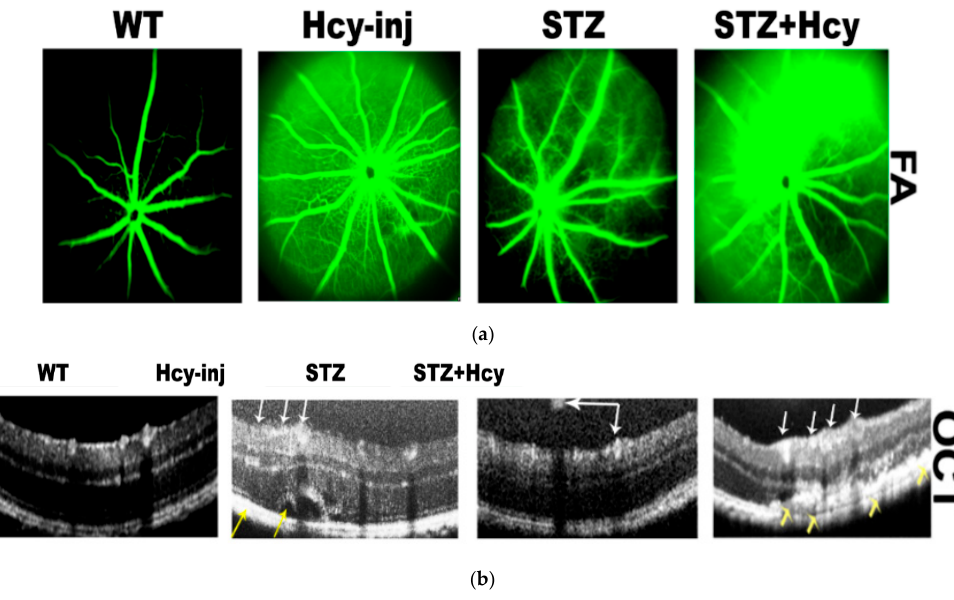
Figure 4. Retinal Fluorescein Angiography (FA) and Optical Coherence Tomography (OCT) assessment of wild-type (WT) mice, Hcy-intravitreal injected mice, STZ-injected mice and Hcy+STZ injected mice (8–10 weeks diabetic). FA demonstrated well-formed vessels in WT mice. FA for Hcy-injected mice showed hyperfluorescence, indicating vascular leakage. Similarly, the FA of STZ-injected mice showed decreased vessel integrity and a disrupted blood–retinal barrier (BRB), indicated by increased fluorescein leakage (pale green haziness). However, the FA of Hcy injected STZ- mice showed focal spots of hyperfluorescence, indicating more significant vascular leakage ( A ). OCT examination showed a typical normal architecture of retinal layers in WT mice, but a disruption of retinal morphology in Hcy-injected mice (white and yellow arrows). These changes were also observed in the OCT of STZ-injected mice. However, the OCT of Hcy+STZ injected mice demonstrated marked structural alteration with sub-retinal fluid leakage and neovascularization in both the inner retina (white arrows) and outer retina (yellow arrows) ( B